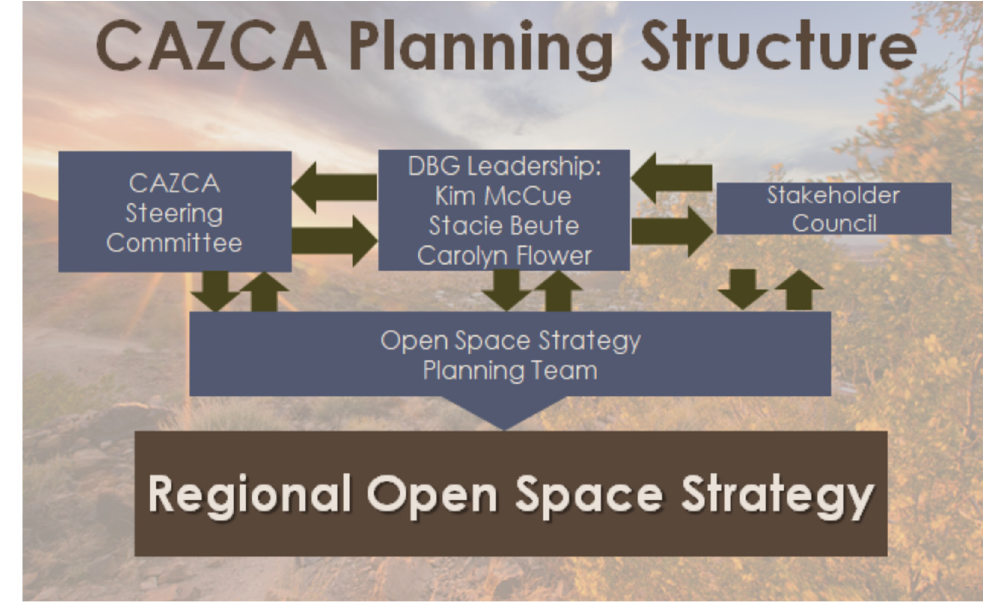
Figure 4. Phase one of the structure that CAZCA utilized in planning the ROSS.